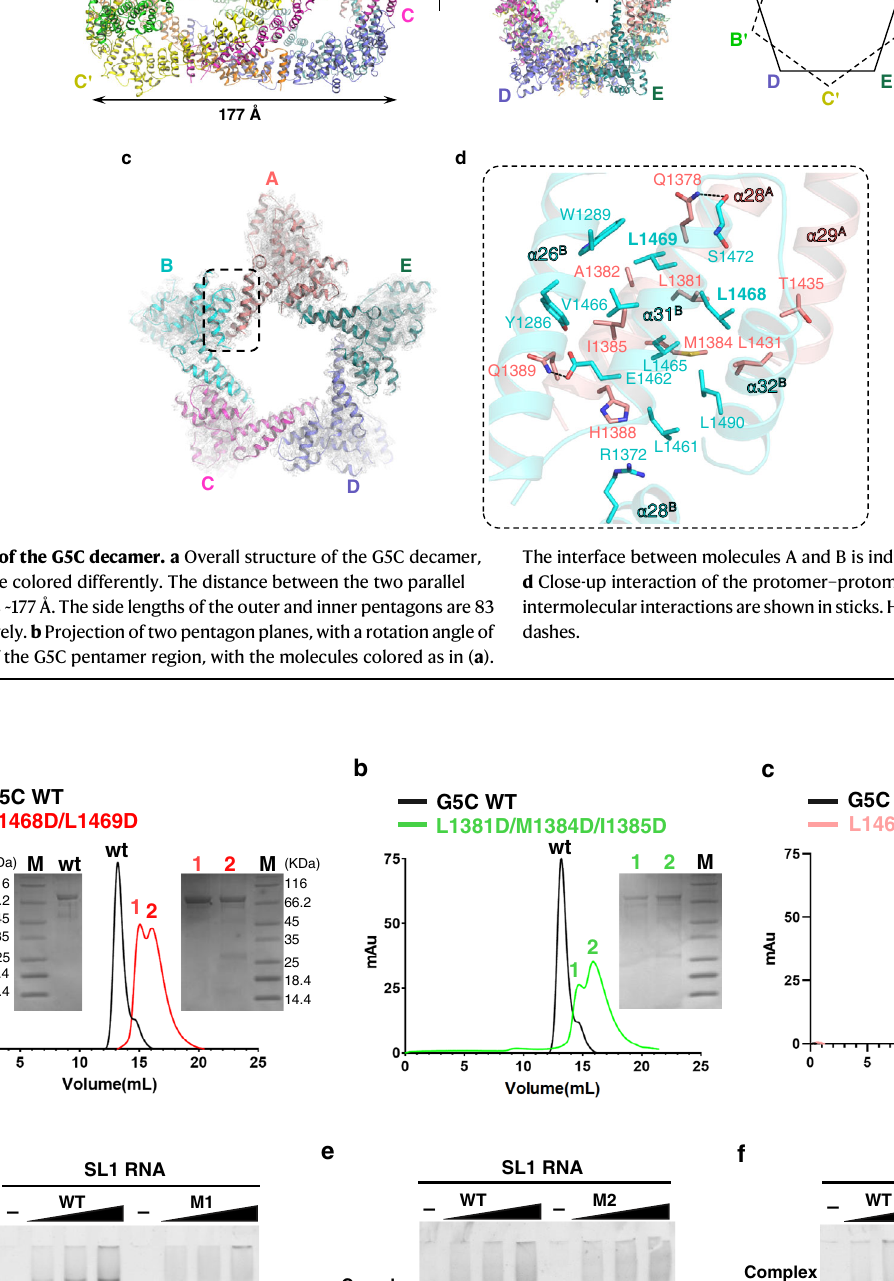
Fig. 4 | Intact pentamer/decamer is required for G5C binding to SL1 RNA. a – c Size-exclusionchromatography(SEC)forG5Cwildtypeandmutants,including ( a ) L1468D/L1469D (M1), b L1381D/M1384D/I1385D (M2), and c L1469H (M3). The same molecular weight marker was used in ( a – c ). d – f EMSA for SL1 RNA binding